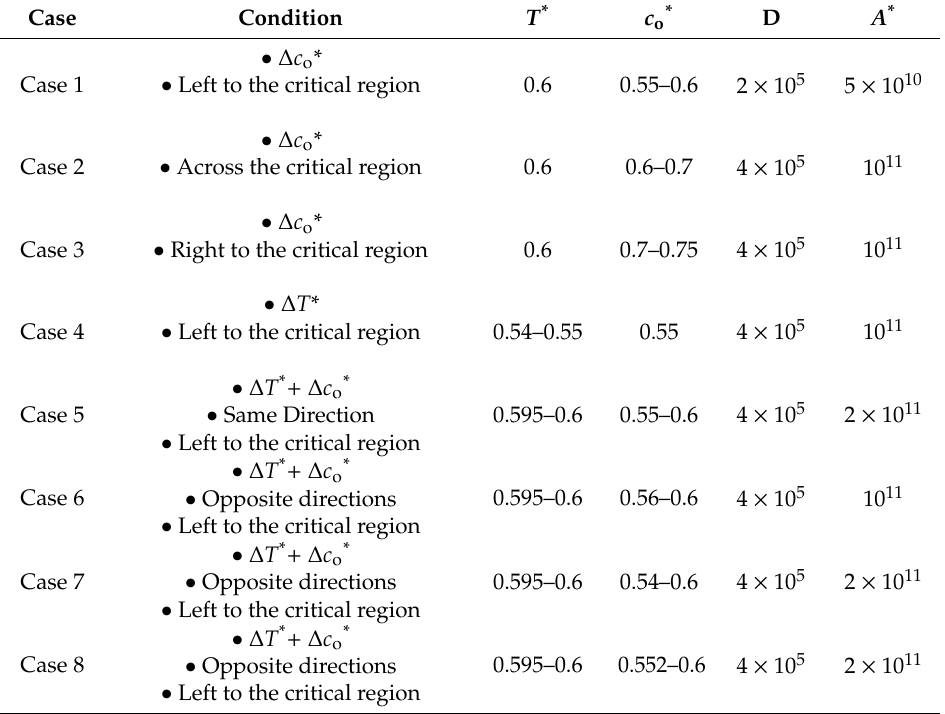
Table 1. The parameters are defined for the eight cases studied in the current work. For all cases, E ∗ a = 10 and ψ =